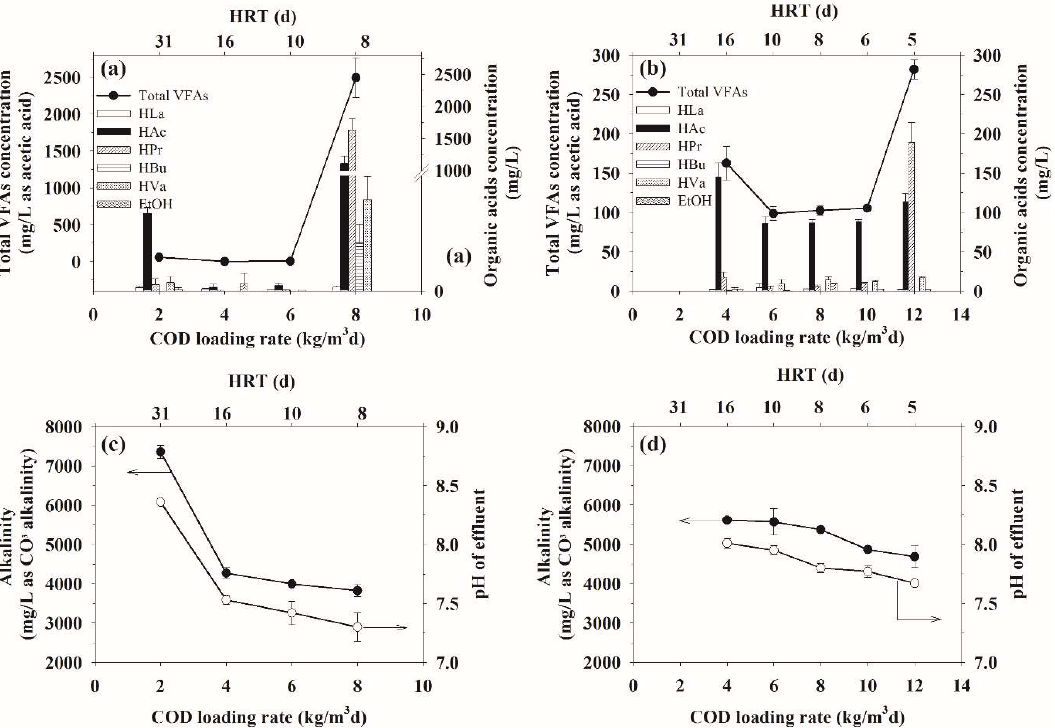
Figure 3. The ( a , b ) total volatile fatty acids (VFA), VFA composition and ethanol concentration and the ( c , d ) alkalinity and effluent pH in the ASBR operated at different COD loading rates under a ( a , c ) mesophilic and ( b , d ) thermophilic temperature. Data are shown as the mean ± 1SD, derived from five independent repeats.